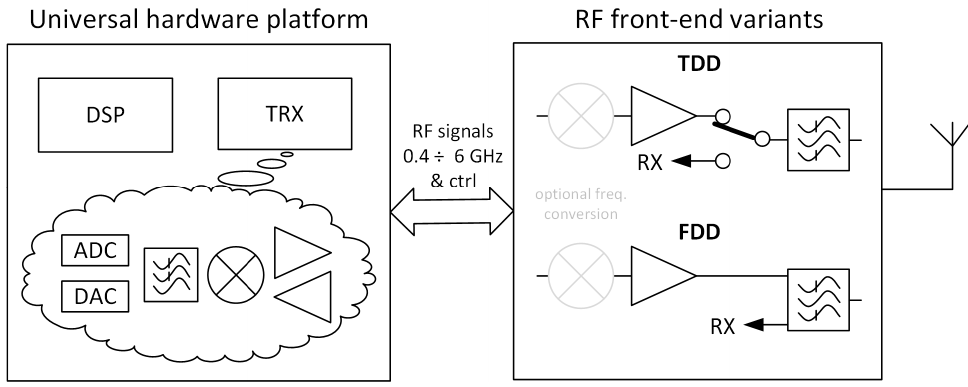
Figure 1. Top-level view of the Universal Hardware Platform architecture.